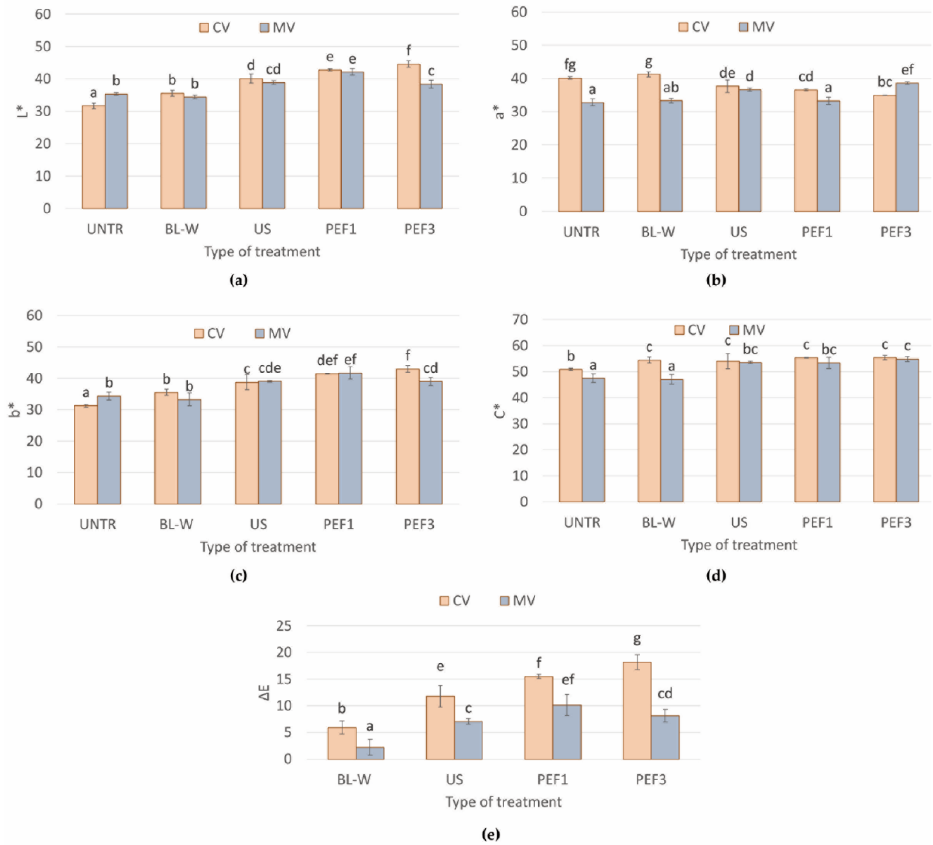
Figure 3. Color parameters: ( a ) L*—lightness, ( b ) a*—share of red color, ( c ) b*—share of yellow color, ( d ) C*—saturation, and ( e ) ∆ E—total color difference (in comparison to untreated dried sample) of convective (CV) and microwave–convective (MV) dried red bell pepper subjected to thermal or non- thermal treatment prior to drying. Column presents a mean (from at least 6 repetitions), and errors bars show standard deviation. The different letters above columns show different homogeneous groups (Tukey’s HSD, α =